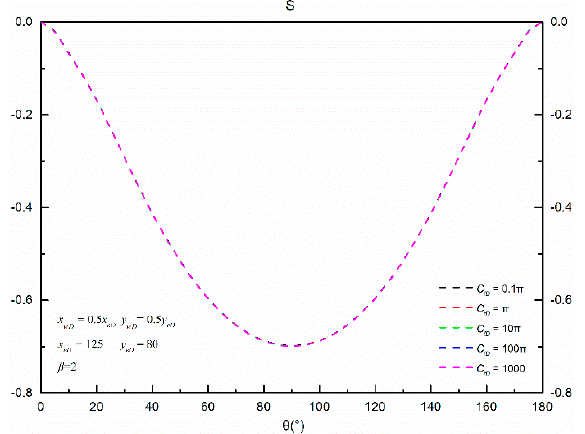
Figure 8. Effect of fracture conductivity on pseudo-skin factor.